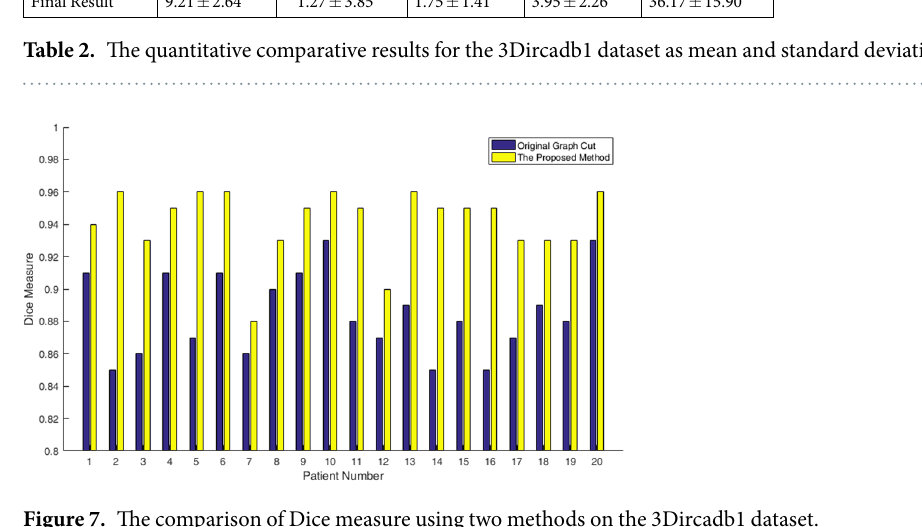
Figure 7. The comparison of Dice measure using two methods on the 3Dircadb1 dataset.